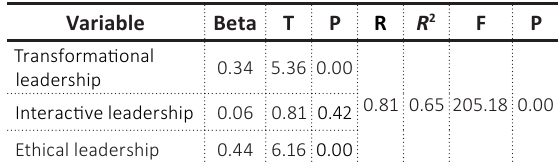
Table 6. The multiple regression results